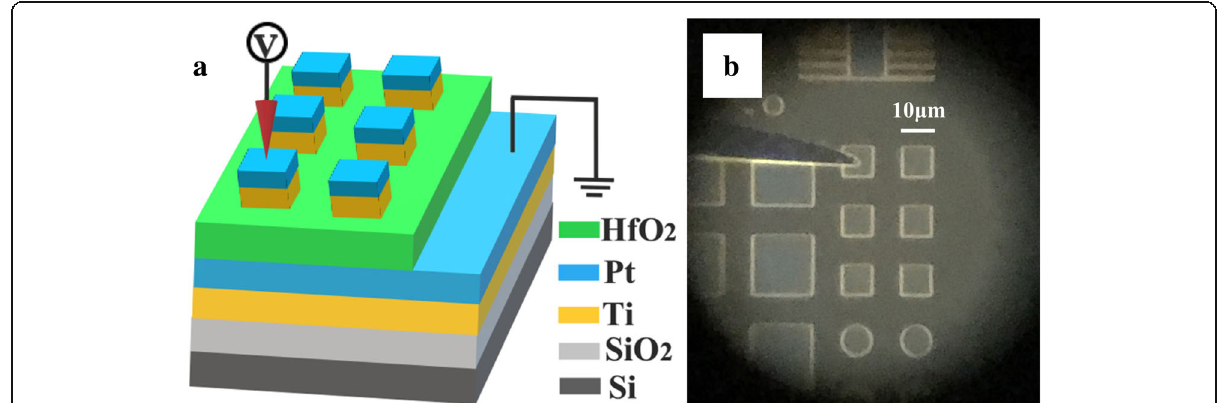
Fig. 1 The structure of the devices. a 3D model of the memristors. b Optical microscopy of the devices